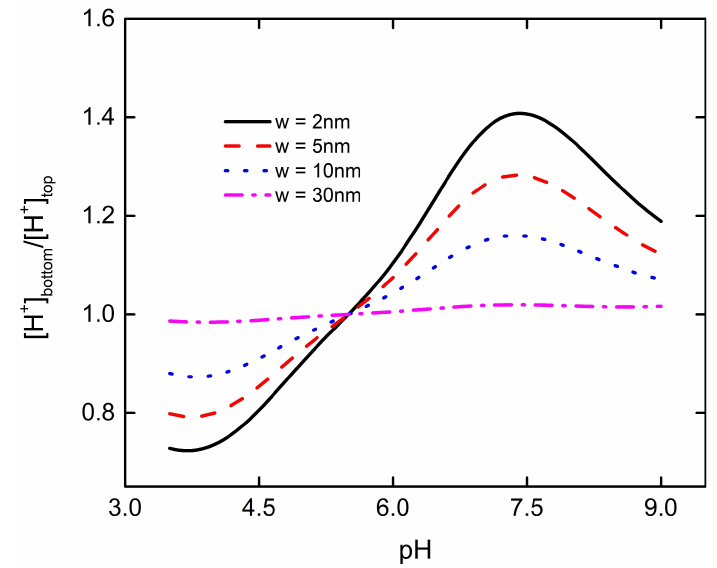
Figure 5. The ratio of the local concentration of H + at the bottom and the top of the particle as a function of pH under di ff erent distances between the particle and the plate at C KCl = 1 mM.